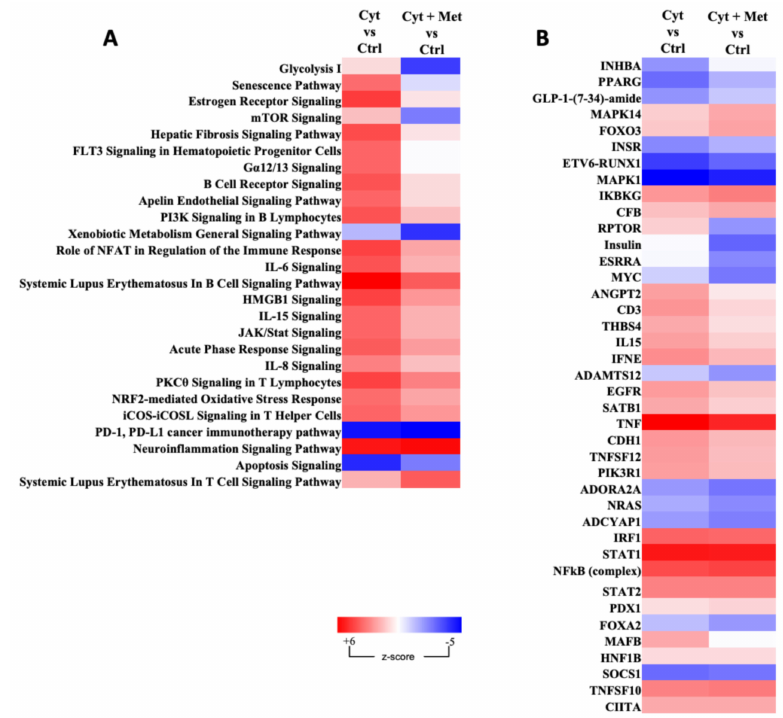
Figure 5. Heat map showing the canonical pathways and upstream regulators differentially regulated by cytokines and cytokines plus metformin vs. the respective control samples. Activated (red) or inhibited (blue) canonical pathways ( A ) and upstream regulators ( B ) obtained by IPA analysis of human islet differentially regulated proteins in the two different comparisons. The brighter the color, the more intense the change is. Canonical pathways (panel A ) were selected based on the highest differences in z-score